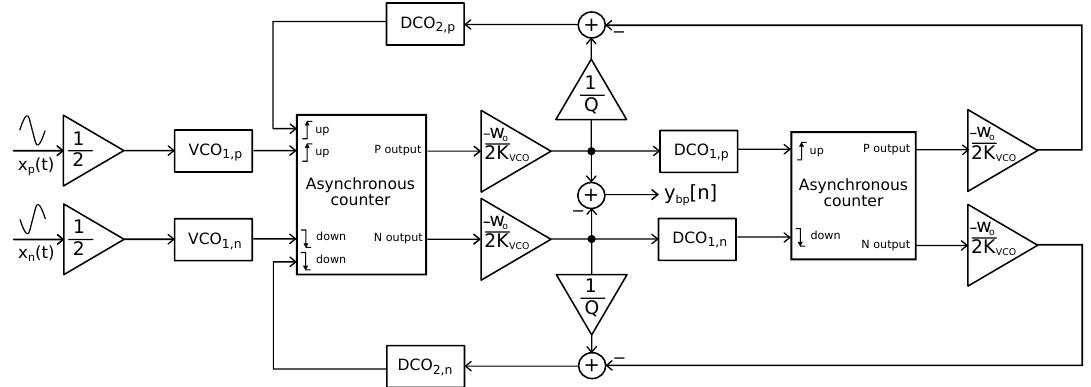
Figure 7. Pseudo-differential configuration of the VCO-based bi-quad